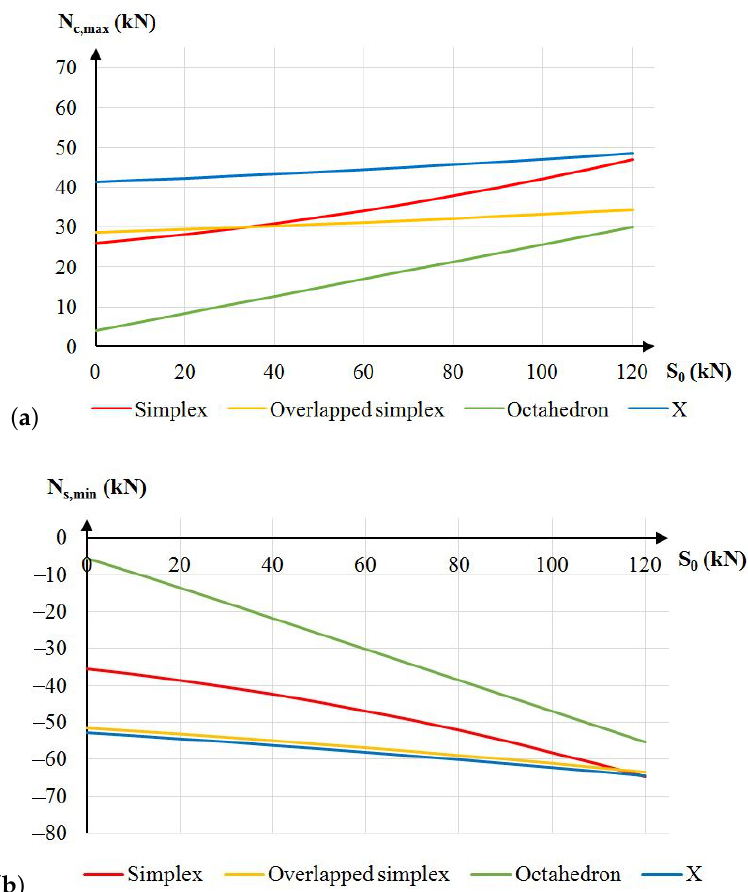
Figure 7. Extreme forces in structural members: ( a ) Maximum tension forces in cables. ( b ) Minimum compression forces in